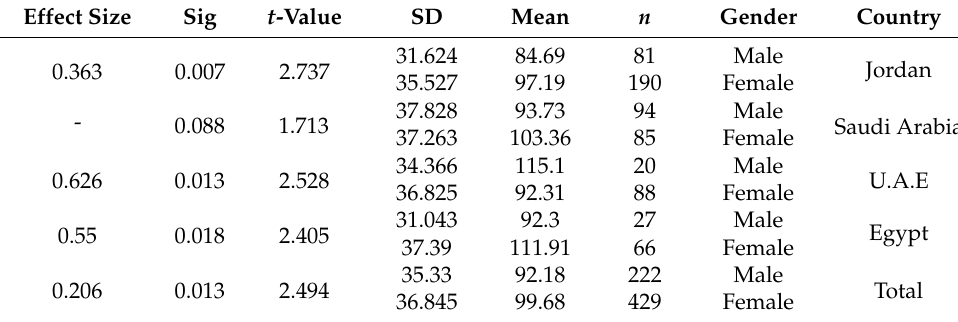
Table 3. t -test for gender differences in anxiety about COVID-19